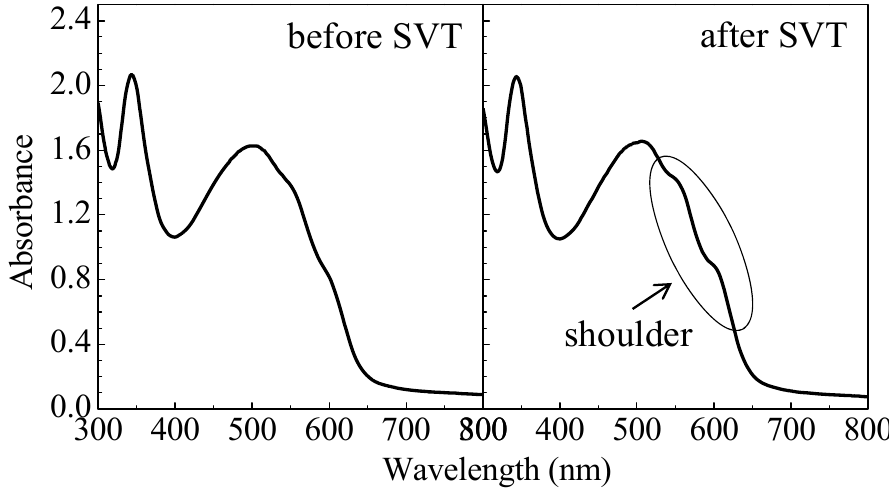
Figure 5. Absorption spectra of the C SVT at 21.6 vol % concentration at 25 °C for 20 min.